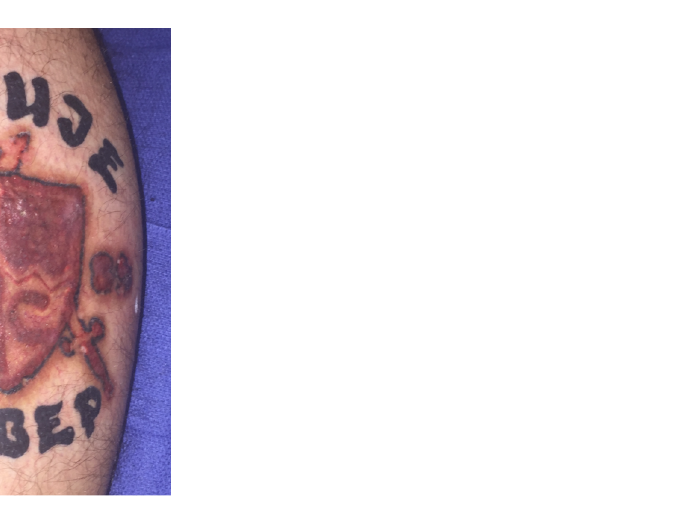
Figure 3. Eighteen months follow up with significant clinical improvement after management with six sessions of intra-lesional steroid injections and topical corticosteroid. The tattoo is no longer raised, scaly or pruritic. The tattoo is largely preserved with an acceptable aesthetic outcome.